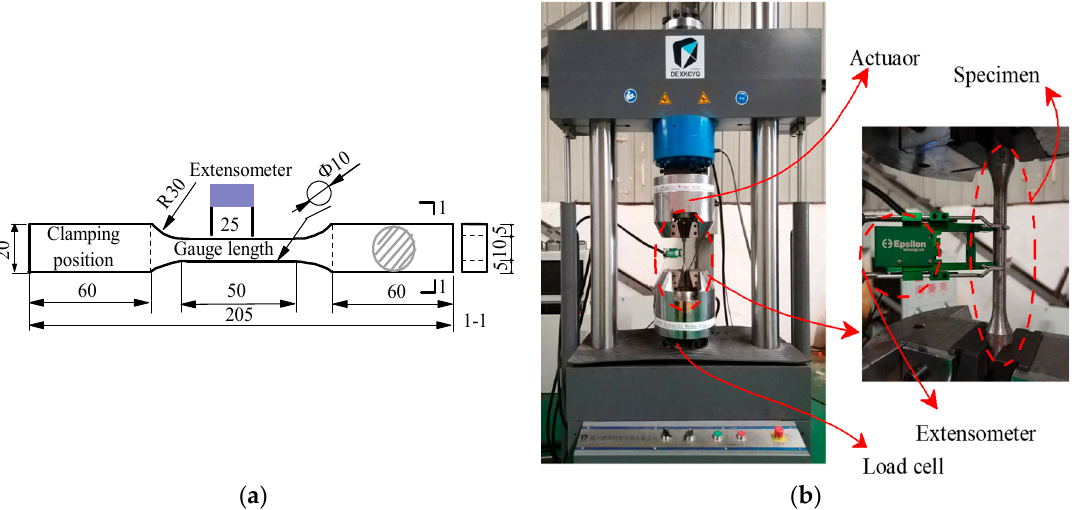
Figure 3. Experimental specimen and setup. ( a ) Dimensions of specimen (mm); ( b ) Experimental setup and instrumentation.